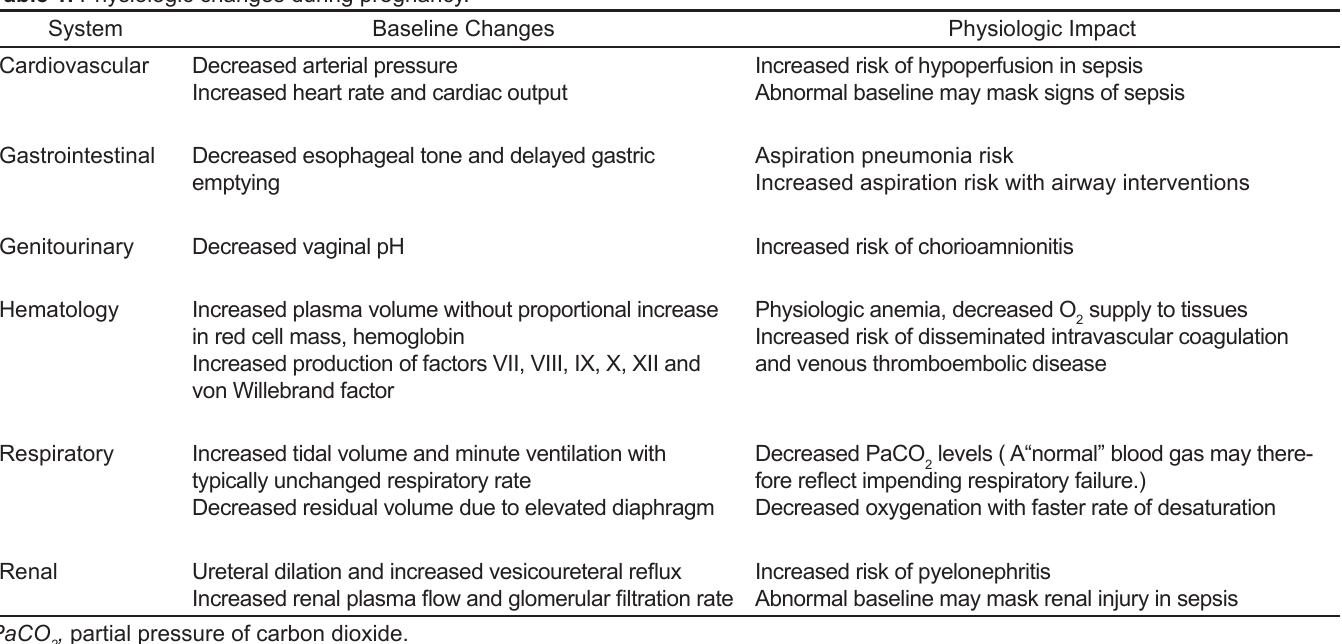
Table 1. Physiologic changes during pregnancy.